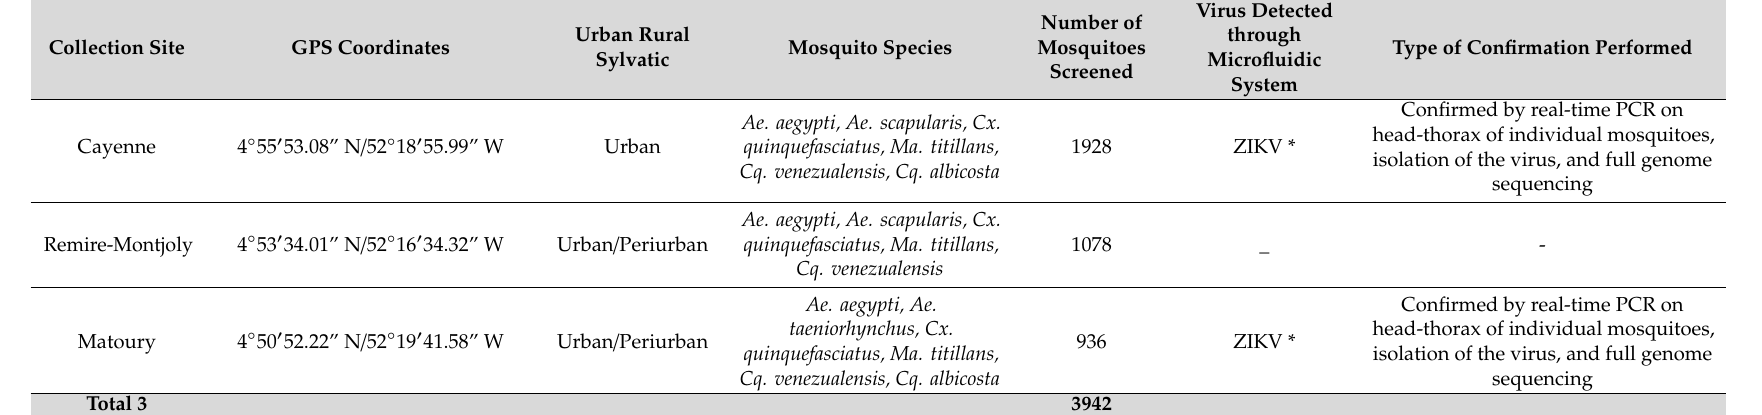
Table 5. Mosquito species, number of mosquitoes collected, and virus detected in French